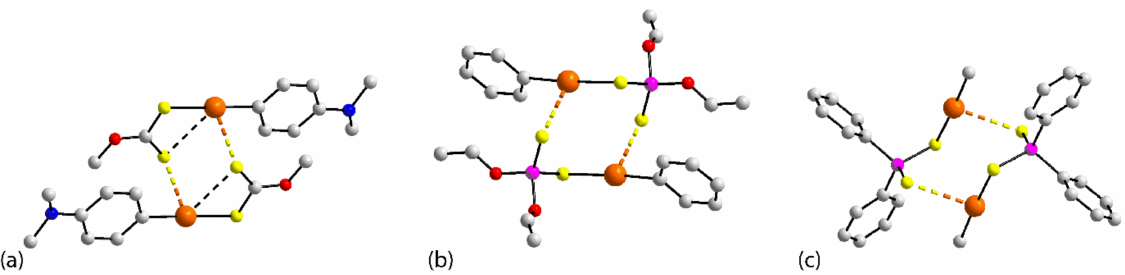
Figure 4. Supramolecular association in zero-dimensional aggregates featuring two Hg ··· S interac- tions: ( a ) 18 , ( b ) 19 and ( c ) 20 .